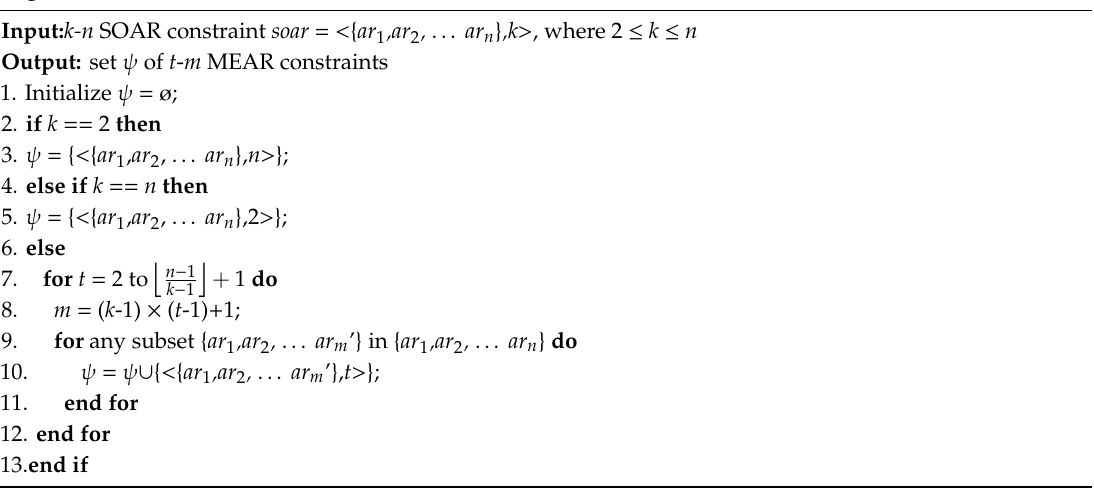
Algorithm 3 Construction of t - m MEAR